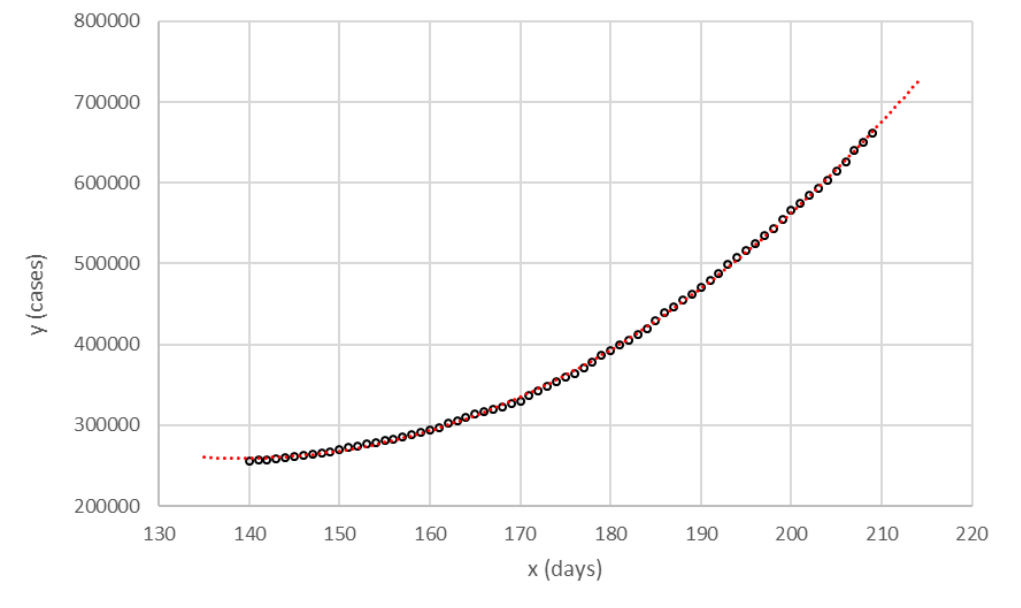
Figure 1. Second pandemic wave in Spain: fit by linear regression of the observed cumulative number of cases to a third-degree polynomial, y = 0.08307 x 3 + 42.281 x 2 − 16,584 x + 1,524,253 (red curve), from 12 July ( x = 140) to 19 September ( x =